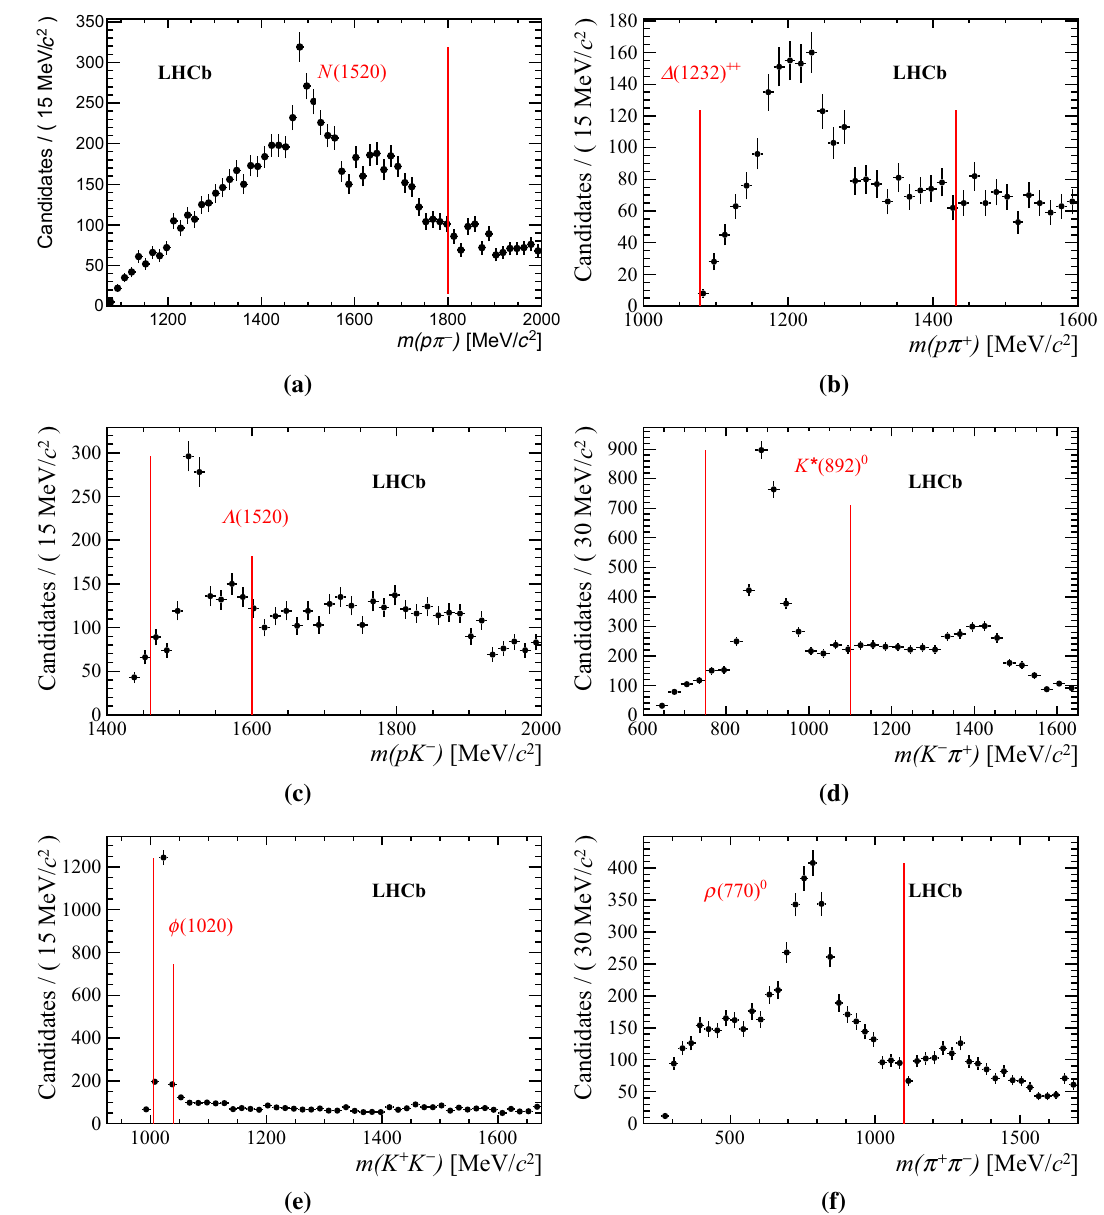
Fig. 1 Distributions of invariant masses of pairs of final-state particles for the candidates selected in the mass window of ± 3 σ around the mea- sured Λ 0 mass. a – c Show the two-body invariant-mass distributions of b → pK − π + π − decays and pK − baryonic p π − , p π + pairs from Λ 0 b → pK − K + K − decays, respectively. Structures around pairs from Λ 0 b known the masses of the N ( 1520 ) , Δ( 1232 ) ++ and Λ( 1520 ) baryons